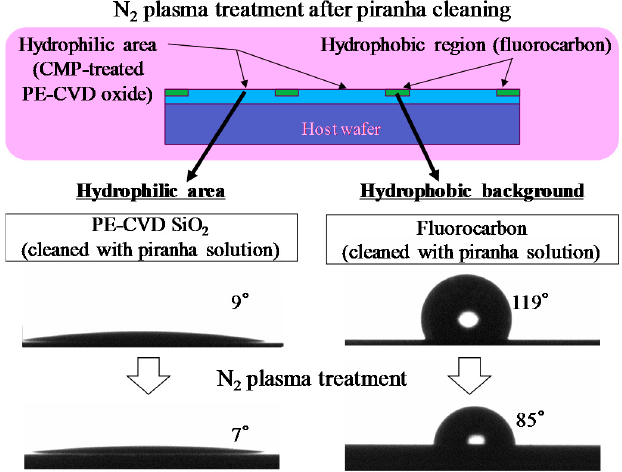
Figure 6. Water contact angles before and after N 2 plasma activation on a hydrophilic assembly area, and hydrophobic background region. Micromachines 2016 , 7 , 184